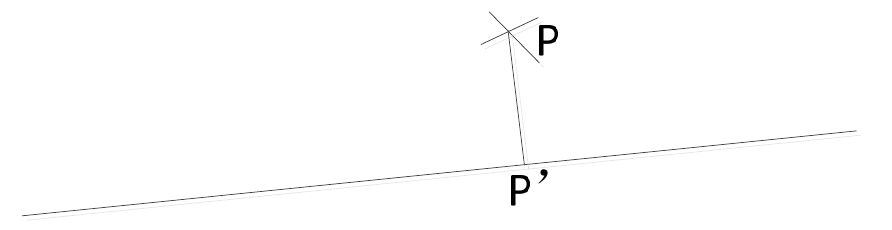
Figure 8. Laser pointer projection on the estimated